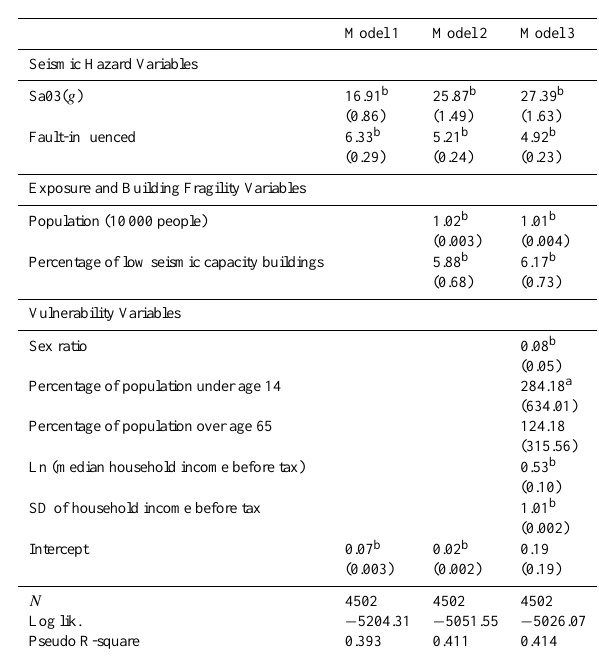
Table 3. Statistical models to estimate seismic fatalities in the 1999 Chi-Chi earthquake: the Poisson regression.